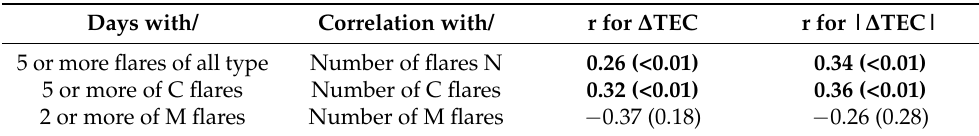
Table 12. Correlation coefficients r between ∆ TEC and SW parameters observed during non-quiet days: days with larger number of flares or geomagnetic disturbances; p values are in parentheses. Statistically significant (95%) r are in bold. Days with/ Correlation with/ r for ∆ TEC r for | ∆